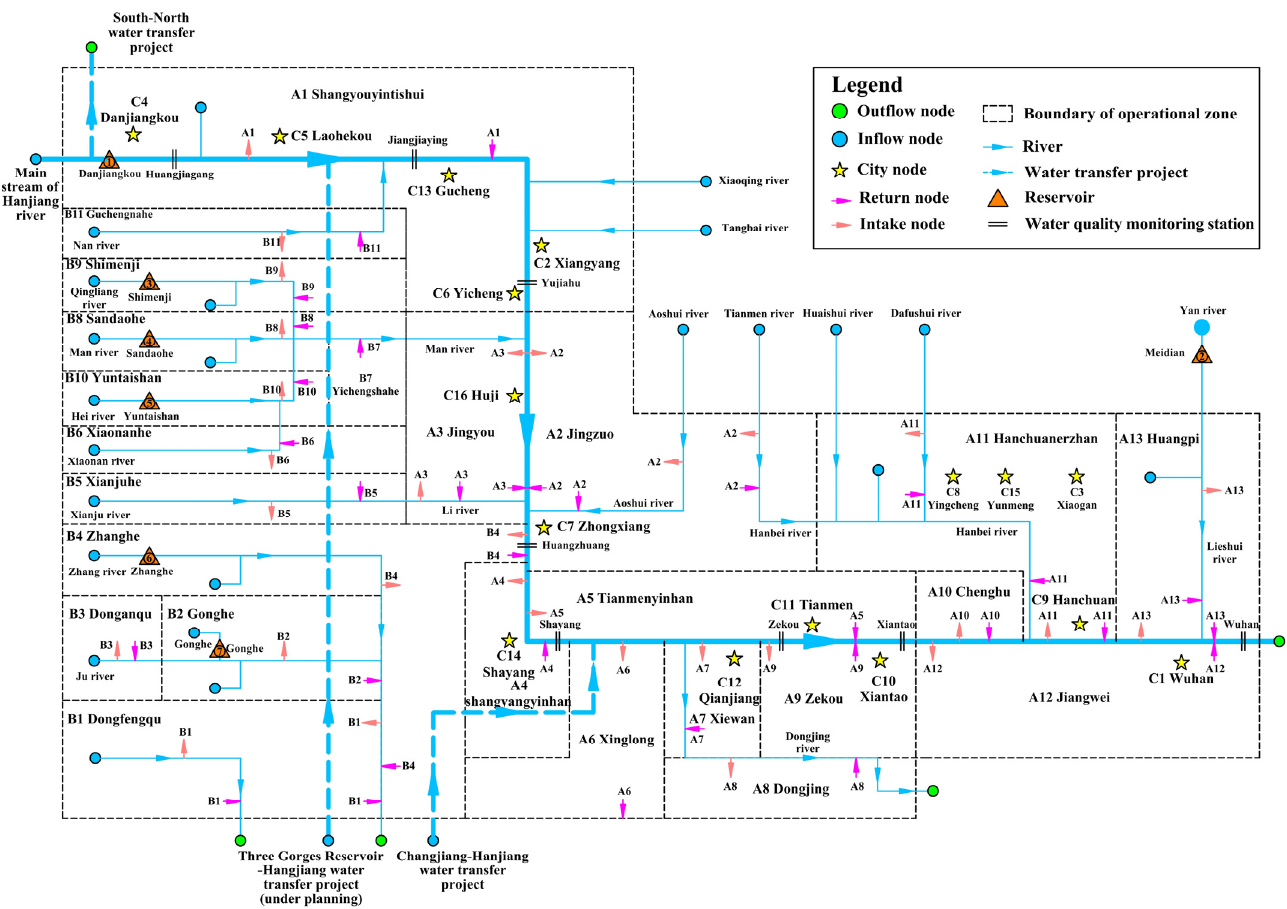
Figure 3. Sketch of the water system for the mid-lower reaches of the Hanjiang River basin.